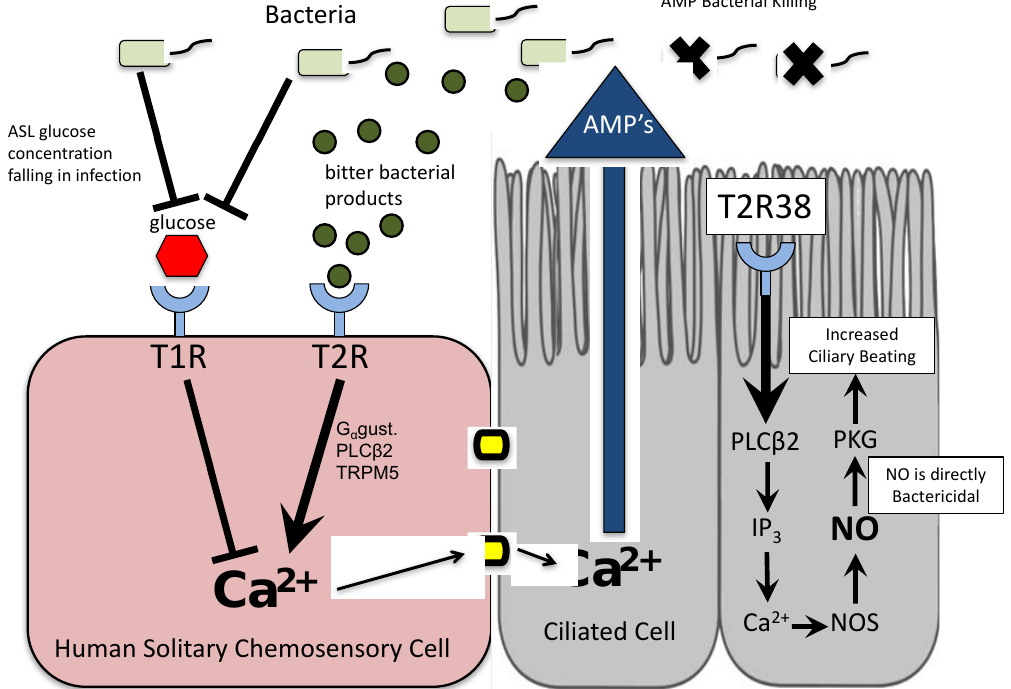
Figure 1. Bitter and sweet taste receptor-induced innate immune defenses in ciliated and solitary chemosensory cells in the human upper airway. ASL: airway surface liquid; AMP: anti-microbial peptide; NOS: nitric oxide synthase; NO: nitric oxide; PKG: protein kinase G.